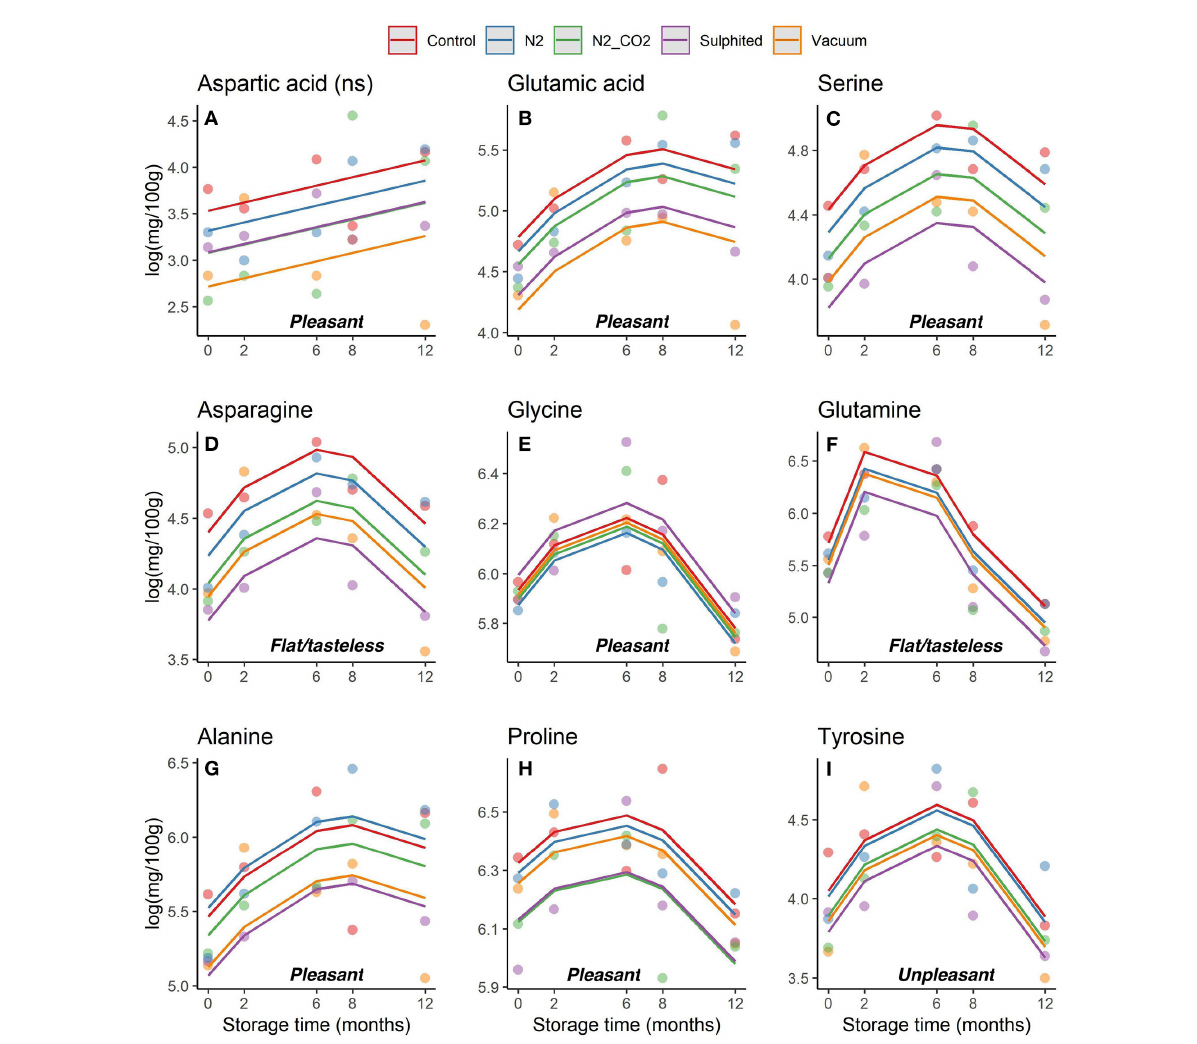
FIGURE5 (A–I) Trends obtained for each non-essential FAA in DWRS samples in relation to the packaging method over 12 months of frozen storage. FAAs were grouped as pleasant, unpleasant, and